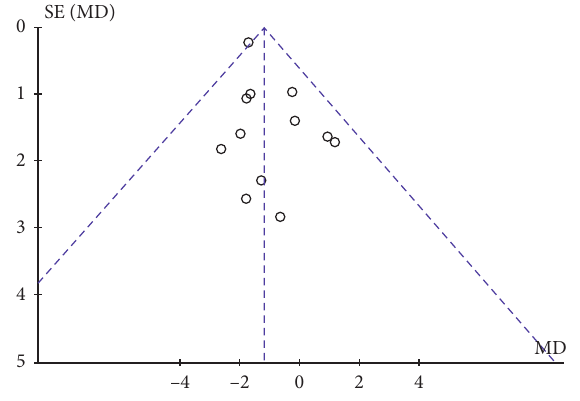
Figure 5: Funnel plot of publication